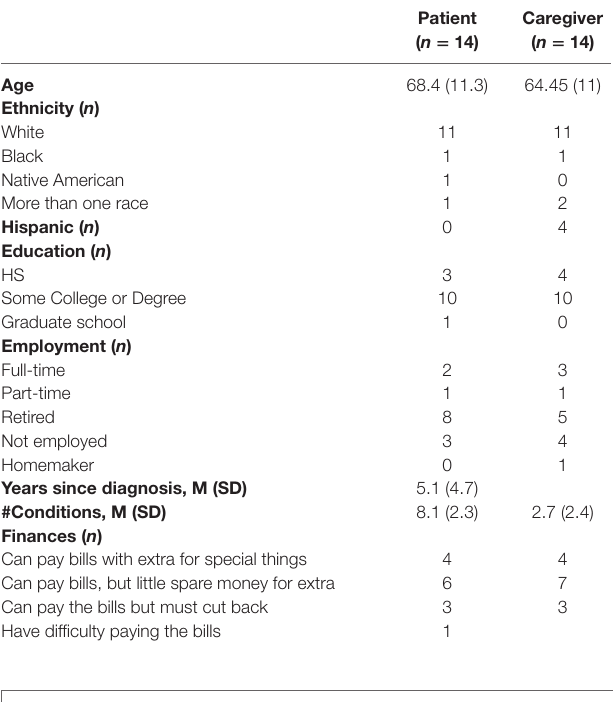
TaBle 2 | Baseline characteristics of participants who completed psychosocial surveys.